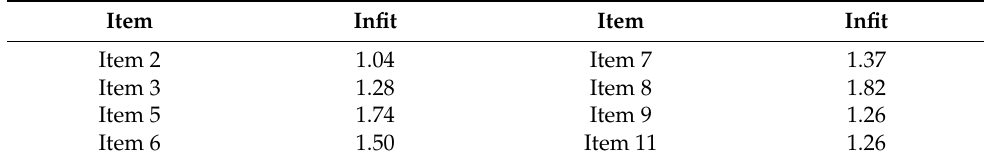
Table 5. WSCS items infit statistics.